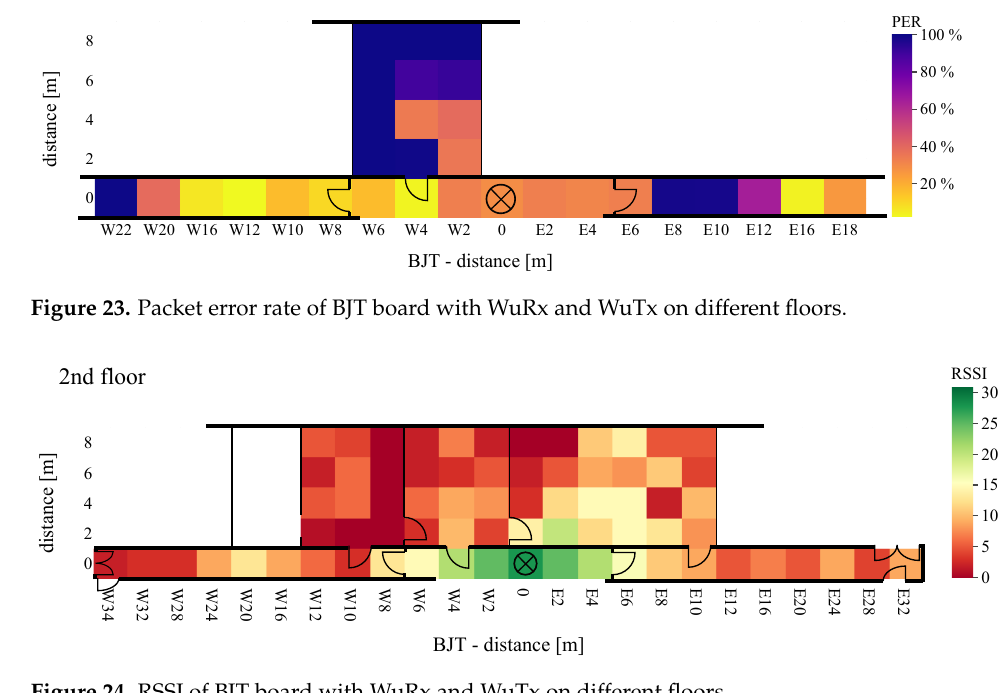
Figure 24. RSSI of BJT board with WuRx and WuTx on different